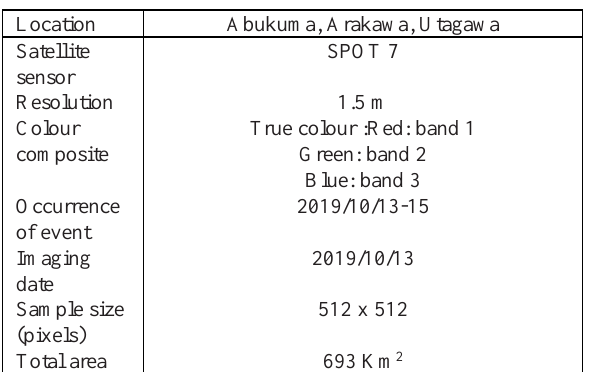
Table 2. Training data sets used in the study